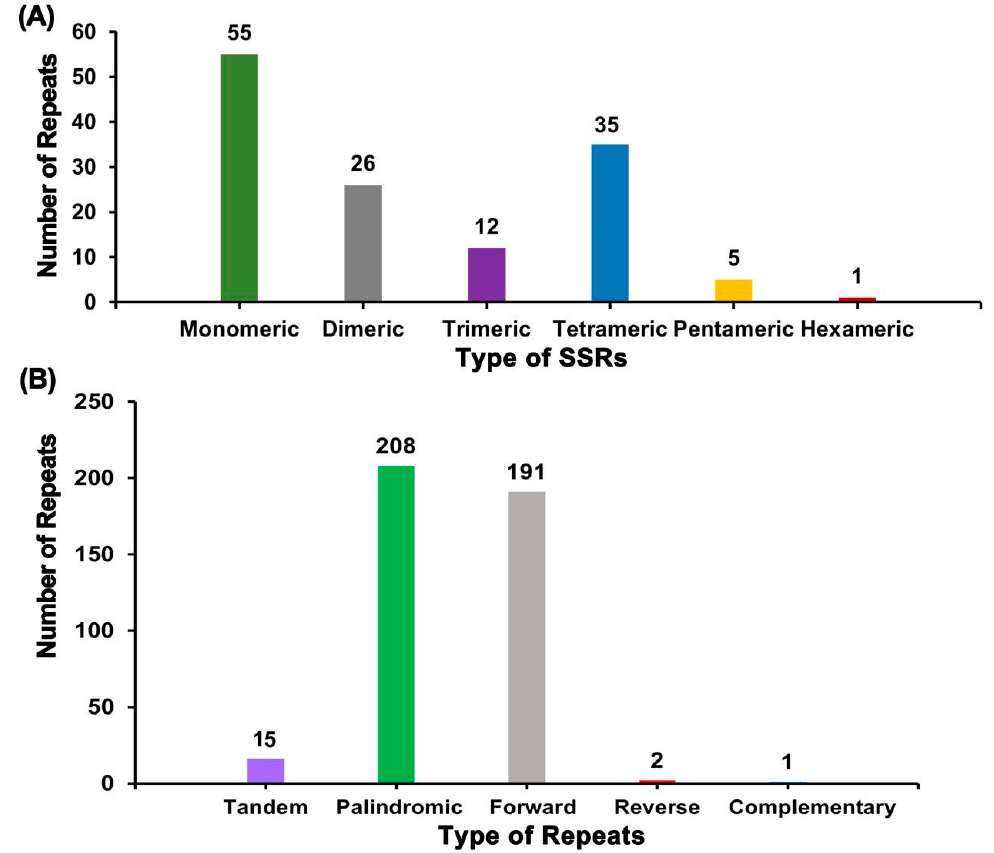
Figure 3. Repeat sequences analysis. ( A ) The horizontal coordinates indicate the type of SSR, and the vertical coordinates indicate the number of repeats. ( B ) The horizontal coordinates indicate the type of repetitive sequence, and the vertical coordinates indicate the number of repeats.